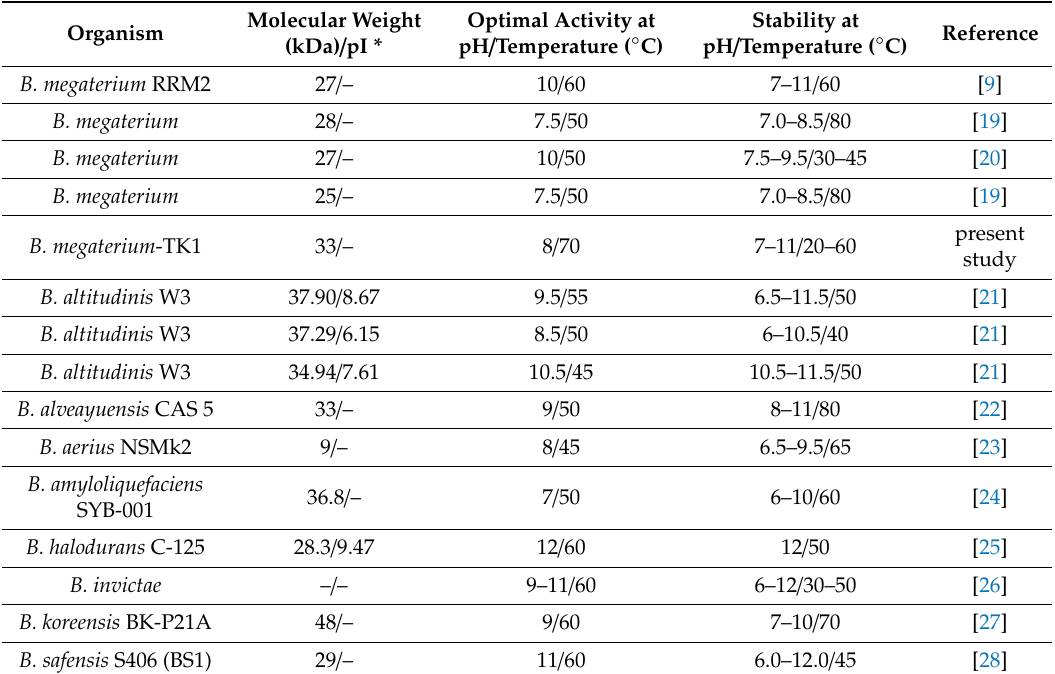
Table 6. The purified protease from our study had a MW of about 33 kDa in SDS-PAGE after Sephadex G-100 gel chromatography (yield: 23.73%, specific activity: 897 U / mg of protein). Asker et al. [19], Rajkumar et al. [9], and Yossana et al. [20] presented proteases from B. megaterium between 25 and 28 kDa (Table 6). Table 6. Comparison of physicochemical properties of various proteases from Bacillus spp. with the purified protease from B. megatarium